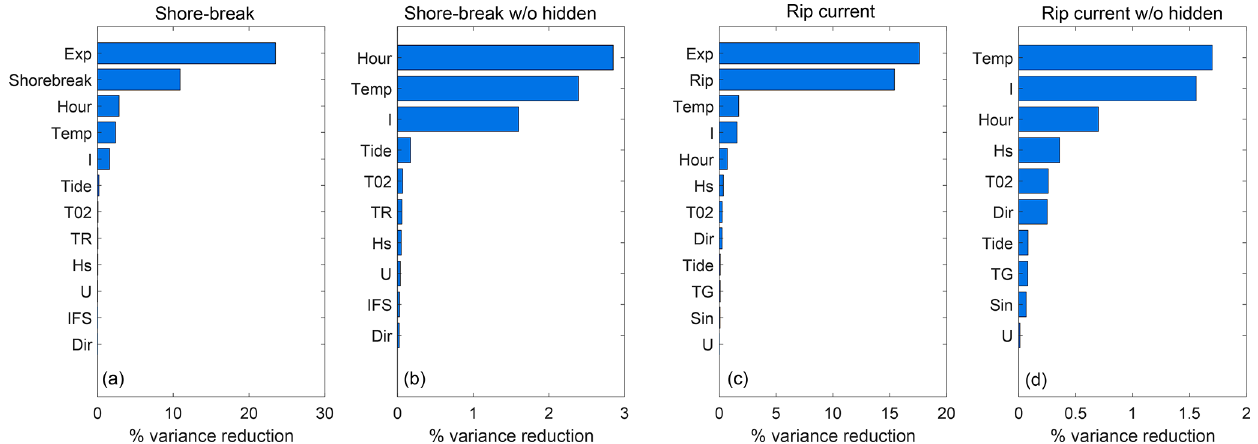
Figure 9. Variance reduction (Vr) without hidden learned variables for the shore-break BN (seven bins) (a) with hidden learned variables and (b) without learned hidden variables and for the rip-current BN (six bins) (c) with hidden learned variables and (d) without hidden learned